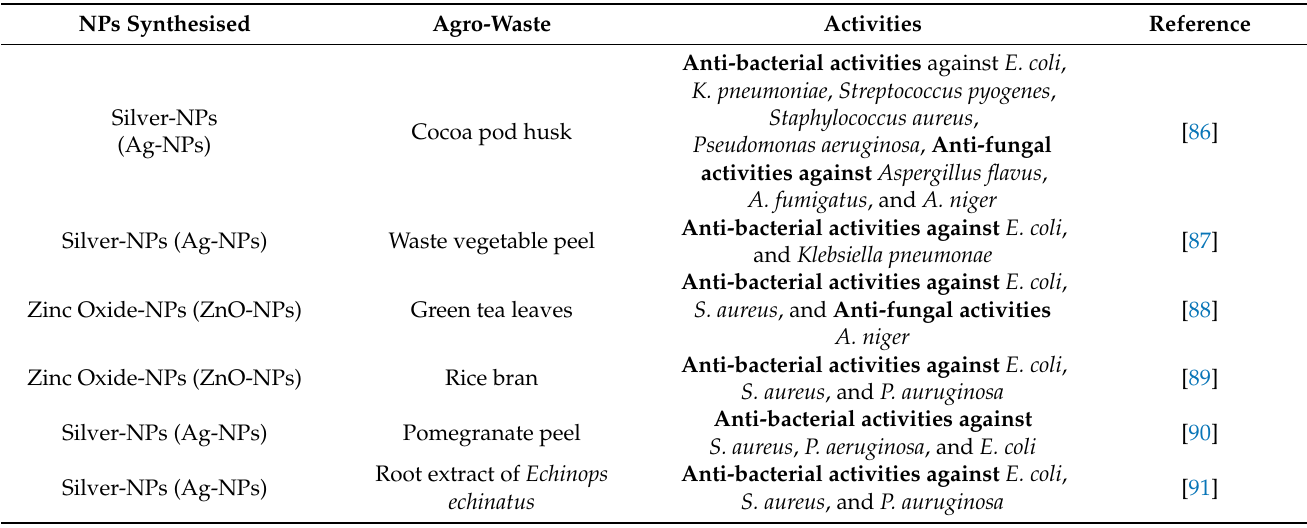
Table 1. Anti-microbial activities of NPs synthesized from